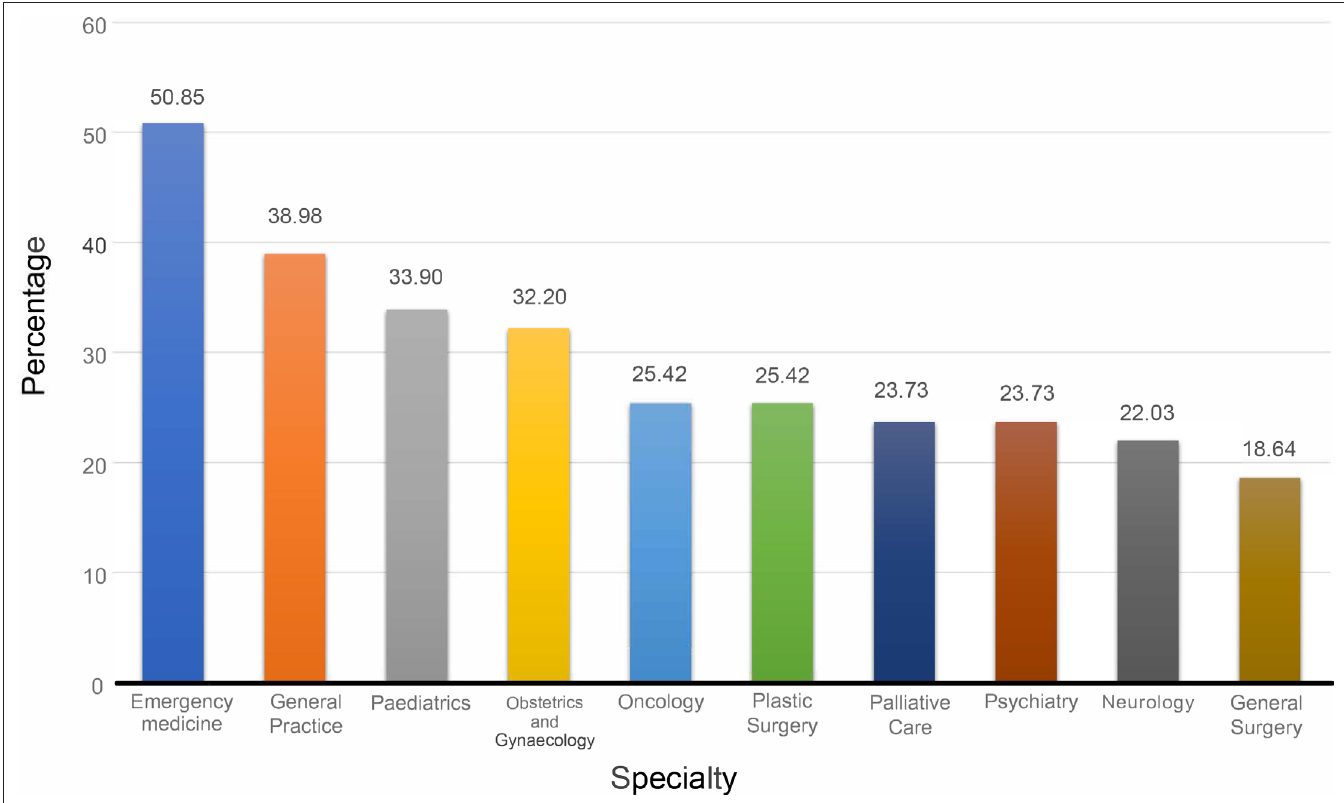
Figure 1 Percentage of students interested in more information, by specialty ( n =